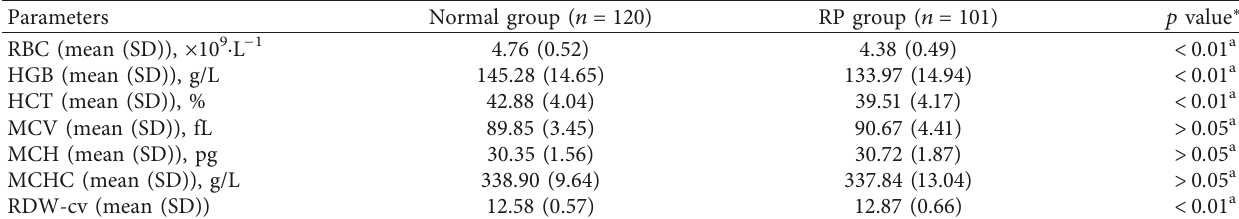
Table 1: Comparison of RBC indicators between the normal and RP group.